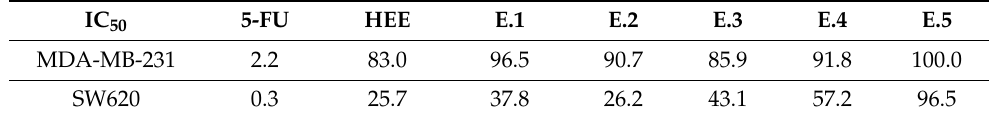
Table 2. IC 50 ( µ g/mL) values for T. articulata trunk bark complete essential oil (HEE) and its fractions